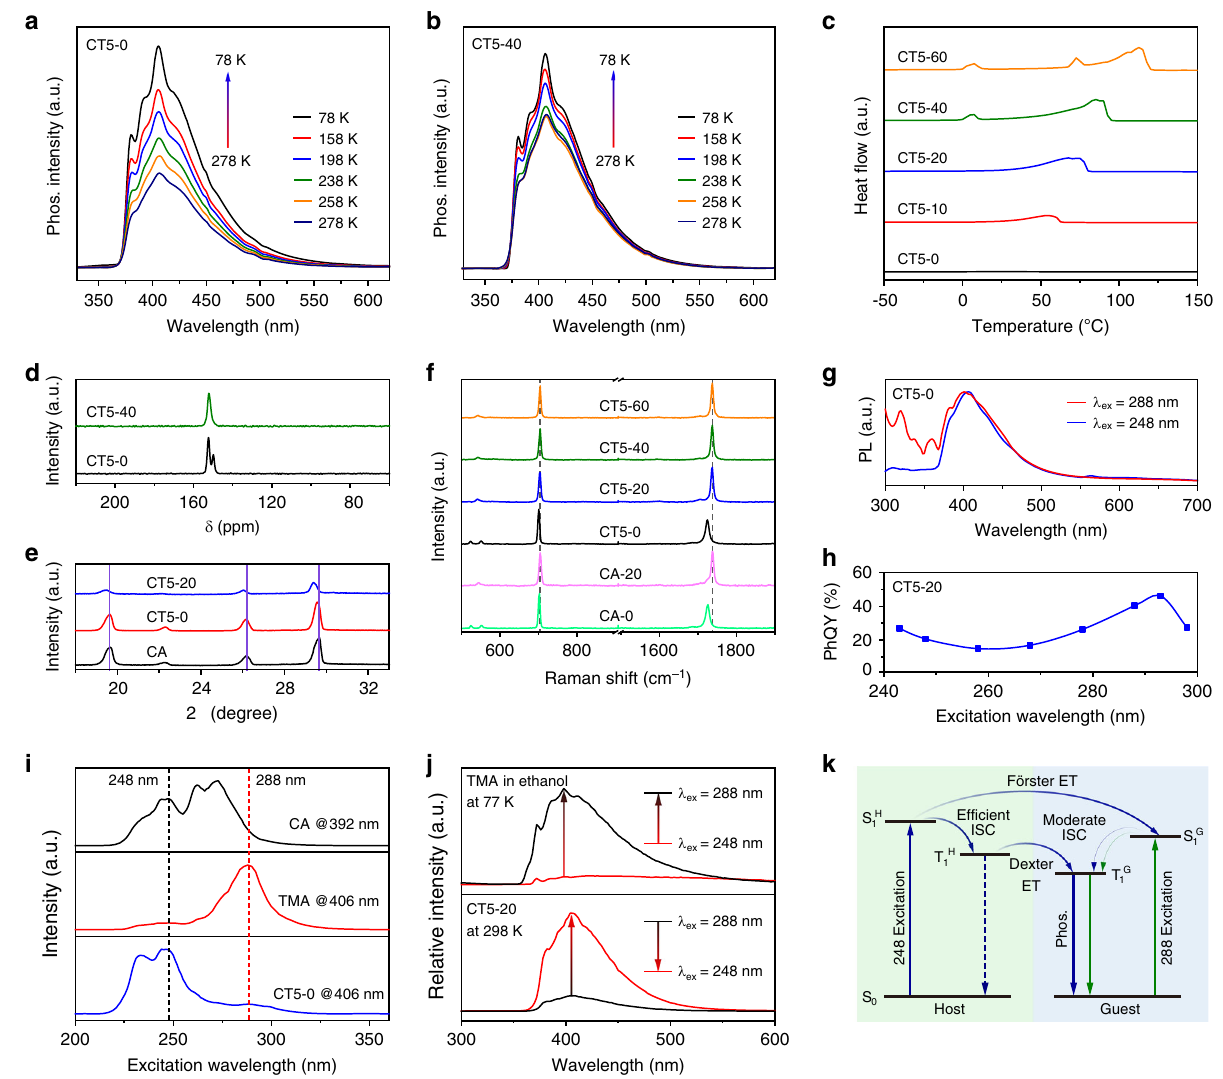
Fig. 3 Mechanism in realizing the highly ef fi cient deep-blue OURTP. a , b Temperature-dependent phosphorescence spectra of CT5-0 ( a ) and CT5-40 ( b ) from 278 to 77 K excited at 248 nm. c DSC curves of CT5 with various water contents. d Solid state 13 C-NMR spectra of CT5-40 and CT5-0. e XRD spectra of CA, CT5-0 and CT5-20. f Raman spectra of CA with 0 (CA-0) and 20 wt% (CA-20) water and CT5 with various water content. g Steady-state PL spectra of CT5-0 excited by 248 (blue) and 288 nm (red) UV-light. h PhQY of CT5-20 at different excitation wavelength. i Excitation spectra of CA and CT5-0 powders and TMA in ethanol. j Phosphorescence spectra of TMA in ethanol at 77 K and CT5-20 at 298 K excited by 248 and 288 nm after 30 ms delay. k Proposed mechanism for the highly luminescent deep-blue